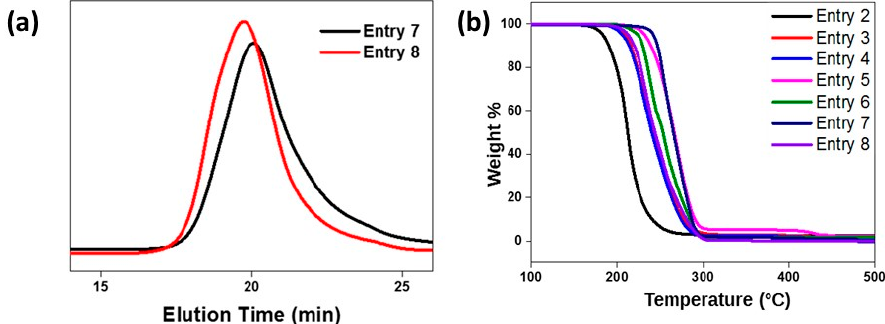
Figure 3. ( a ) GPC elugrams of the terpolymers corresponding to Entries 2–8 in Table 1; ( b ) TGA curves of the poly(ester-co-carbonates) obtained from Entries 2–8 in Table 1.